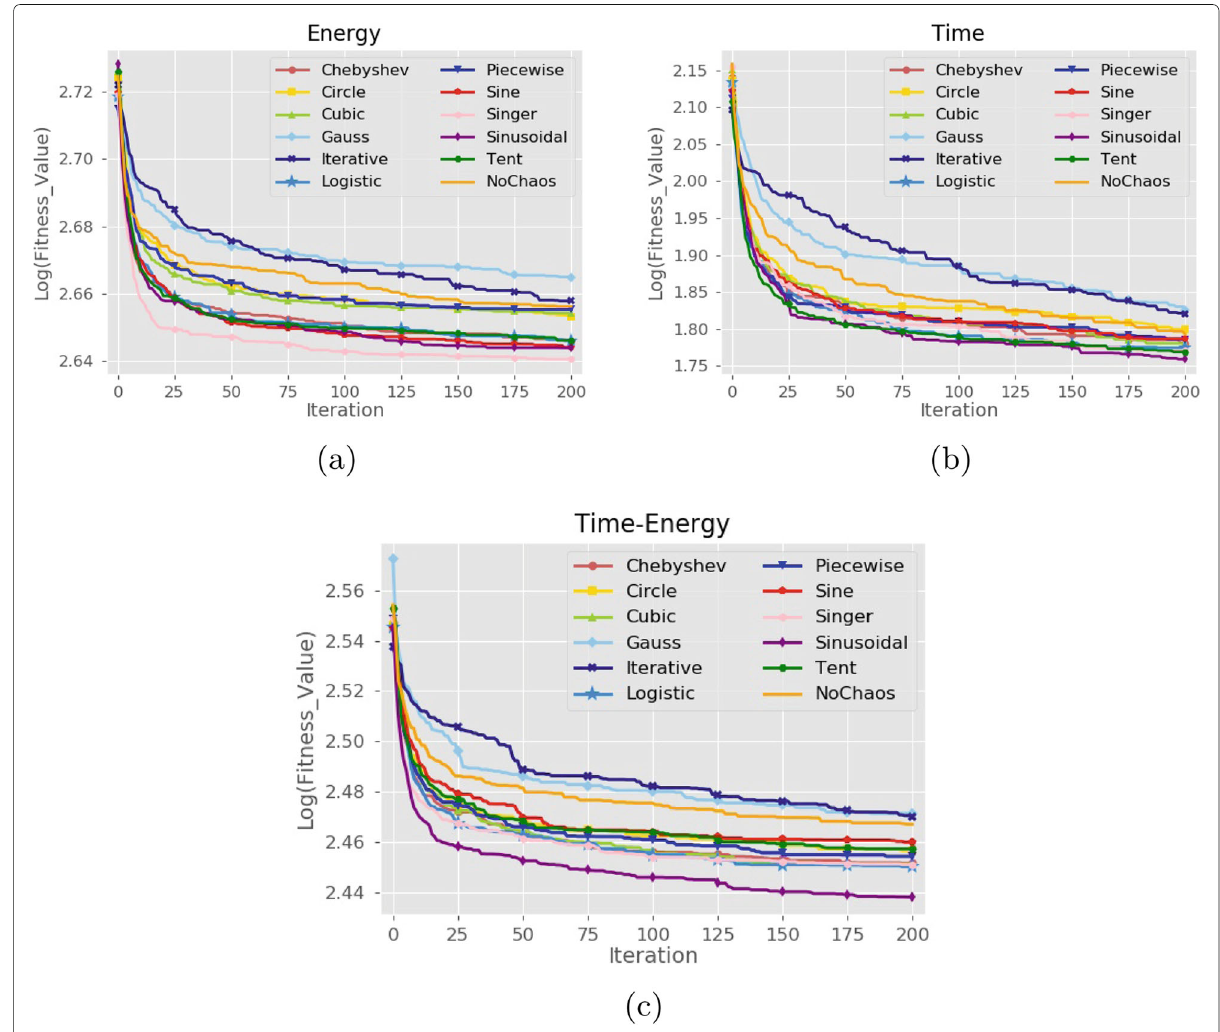
Fig. 8 Performance comparison of 11 chaotic maps for p value